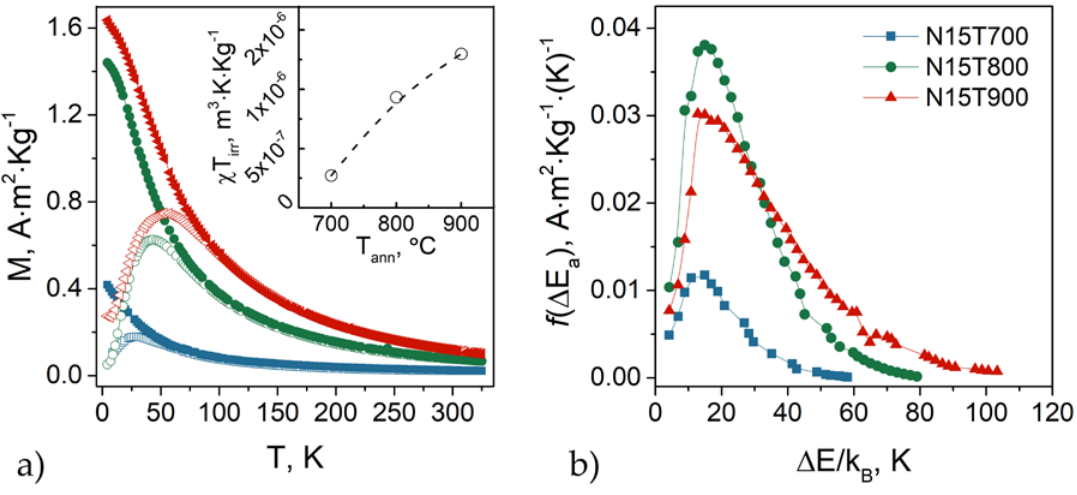
Figure 1. ( a ) Zero-field-cooled (ZFC) (empty symbols) and field-cooled (FC) (solid symbols) magnetization curves. Inset: product of the magnetic susceptibility times the irreversibility temperature as a function of the annealing temperature. ( b ) Energy barrier distribution obtained from the first derivative of the thermoremanent magnetization M TRM ( T ) versus temperature.